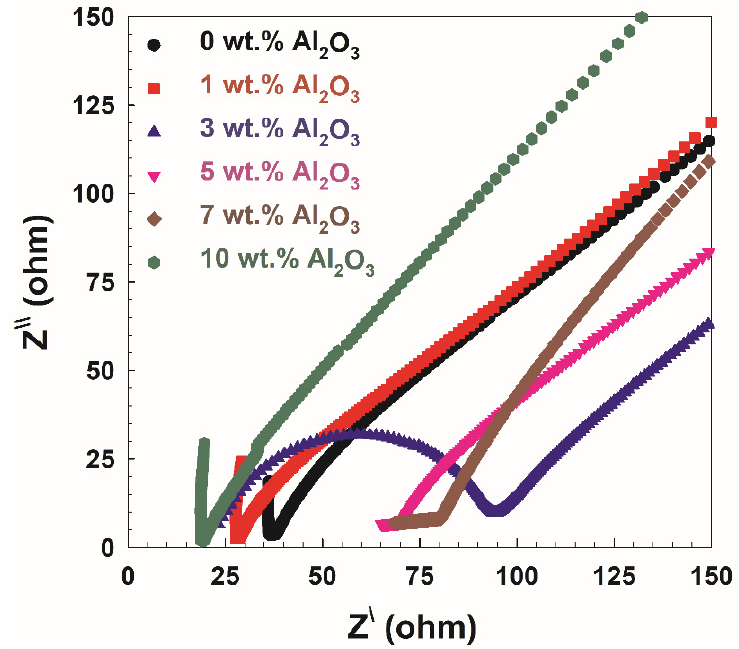
Figure 6. Cole–Cole plot for PVA/10 wt.% PEG polymers and different concentrations of Al 2 O 3 .